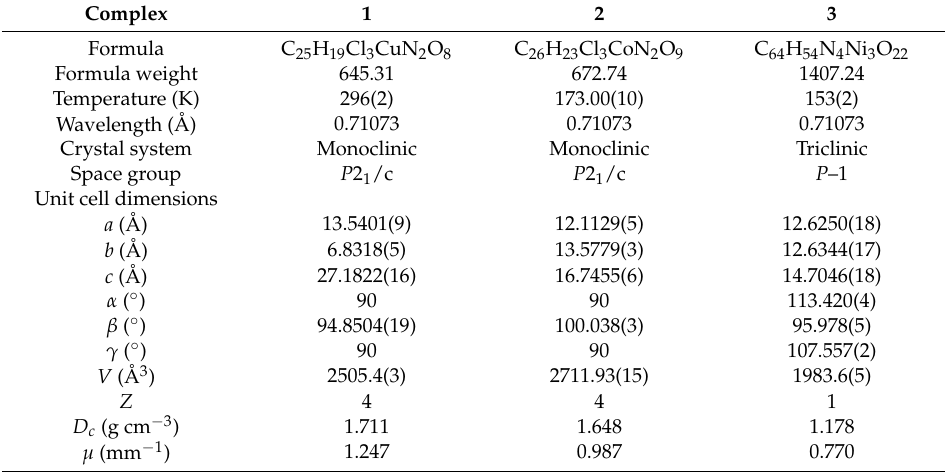
Table 1. Crystal data and refinement parameters for complexes 1 , 2 and 3